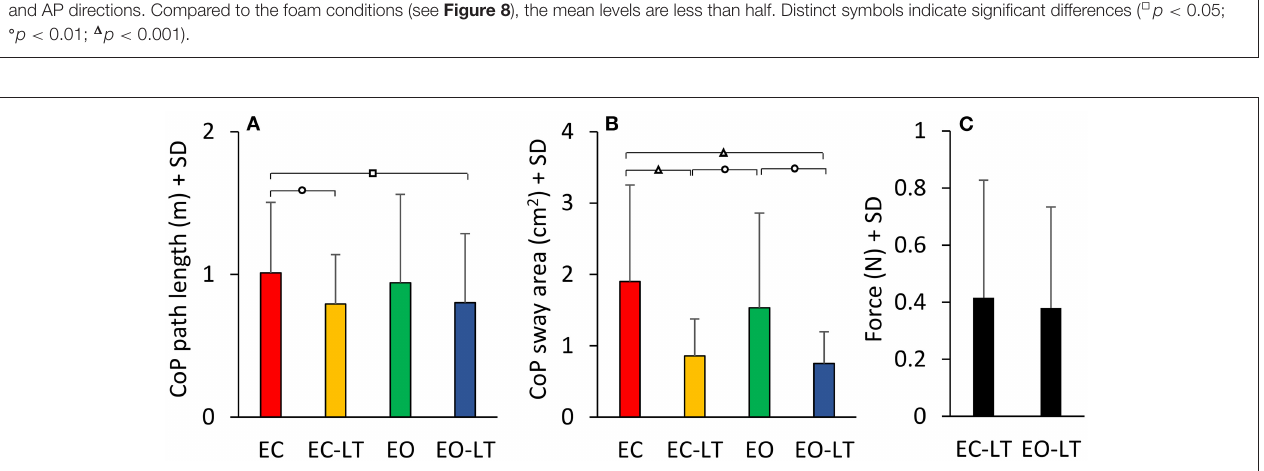
FIGURE 13 | CoP path length and sway area on solid BoS. The path length and 95% ellipse area with the solid BoS are much smaller than in the foam condition. While the path length is not very different across sensory conditions (A) , sway area shows larger differences across conditions, the minimal excursions of the CoP being present when touch is available (B) . In the solid BoS condition, the touch forces (C) are similar, with and without vision. Distinct symbols indicate significant differences ( 2 p < 0.05; ◦ p < 0.01; 1 p <